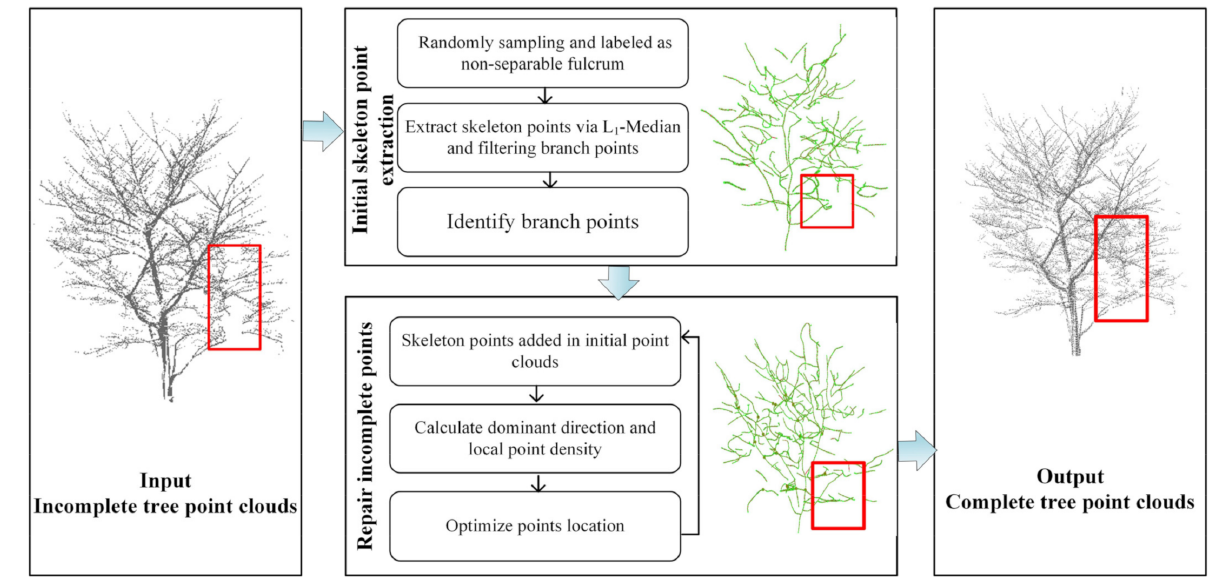
Figure 2. The process of incomplete point cloud repair